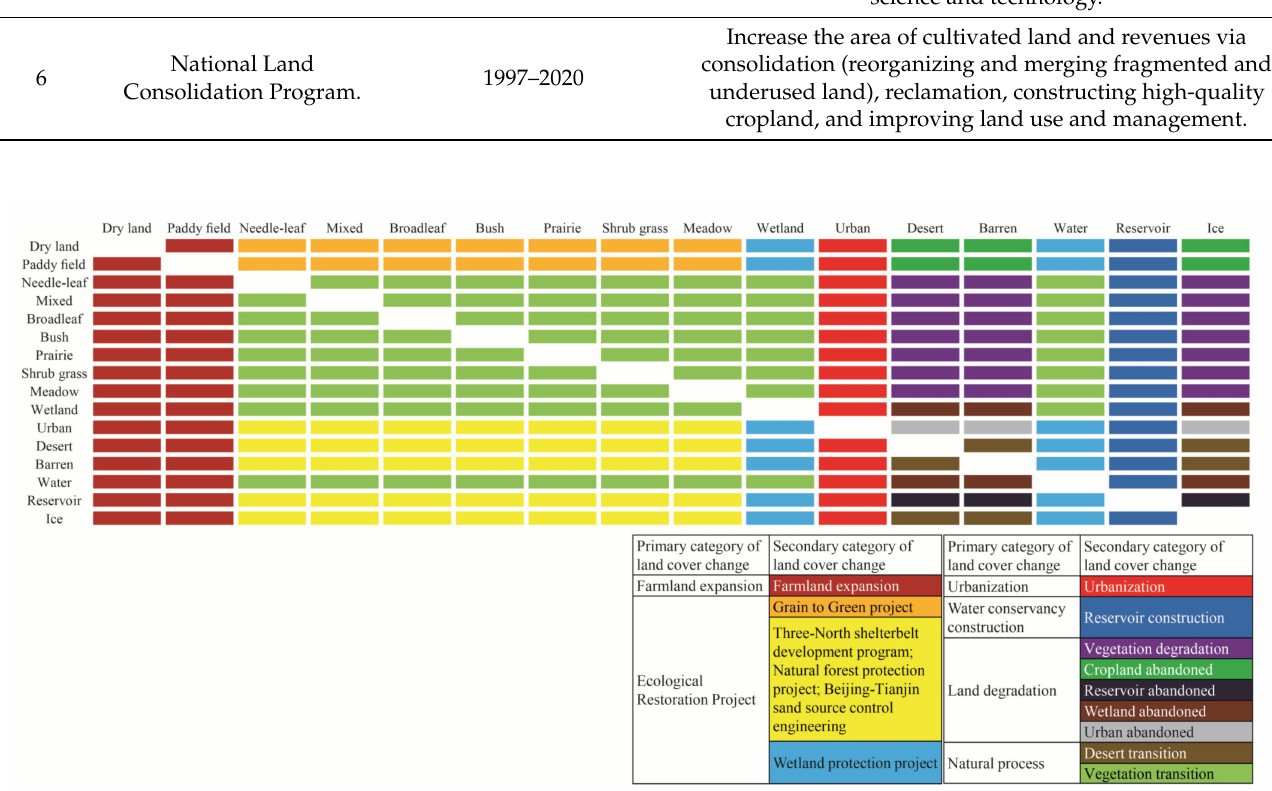
Figure A1. Definition of LULC change.